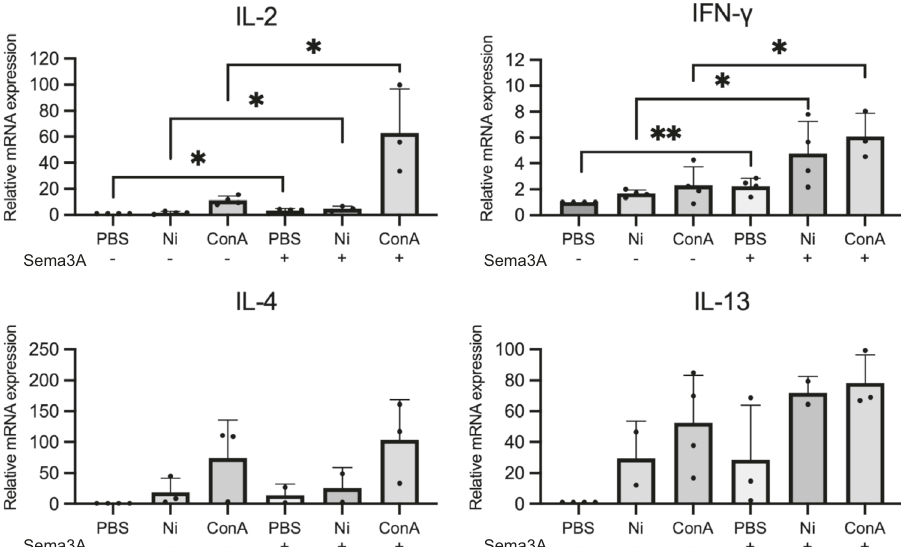
Fig. 7 Sema3A induces T cell differentiation. The mRNA expression of Th1-induced (IL-2 and IFN- γ ) and Th2-induced (IL-4 and IL-13) cytokines in PBS/ Ni/ConA-stimulated splenic T cells in the absence or presence of recombinant Sema3A analyzed using quantitative RT-PCR. Gene expression was normalized to levels of β -actin. N = 4. Data are shown as mean ± SD and are representative of four independent experiments. * p < 0.5, ** p < 0.01. Two independent samples t -test. Supplementary Data and p values are provided as a Supplementary Data fi